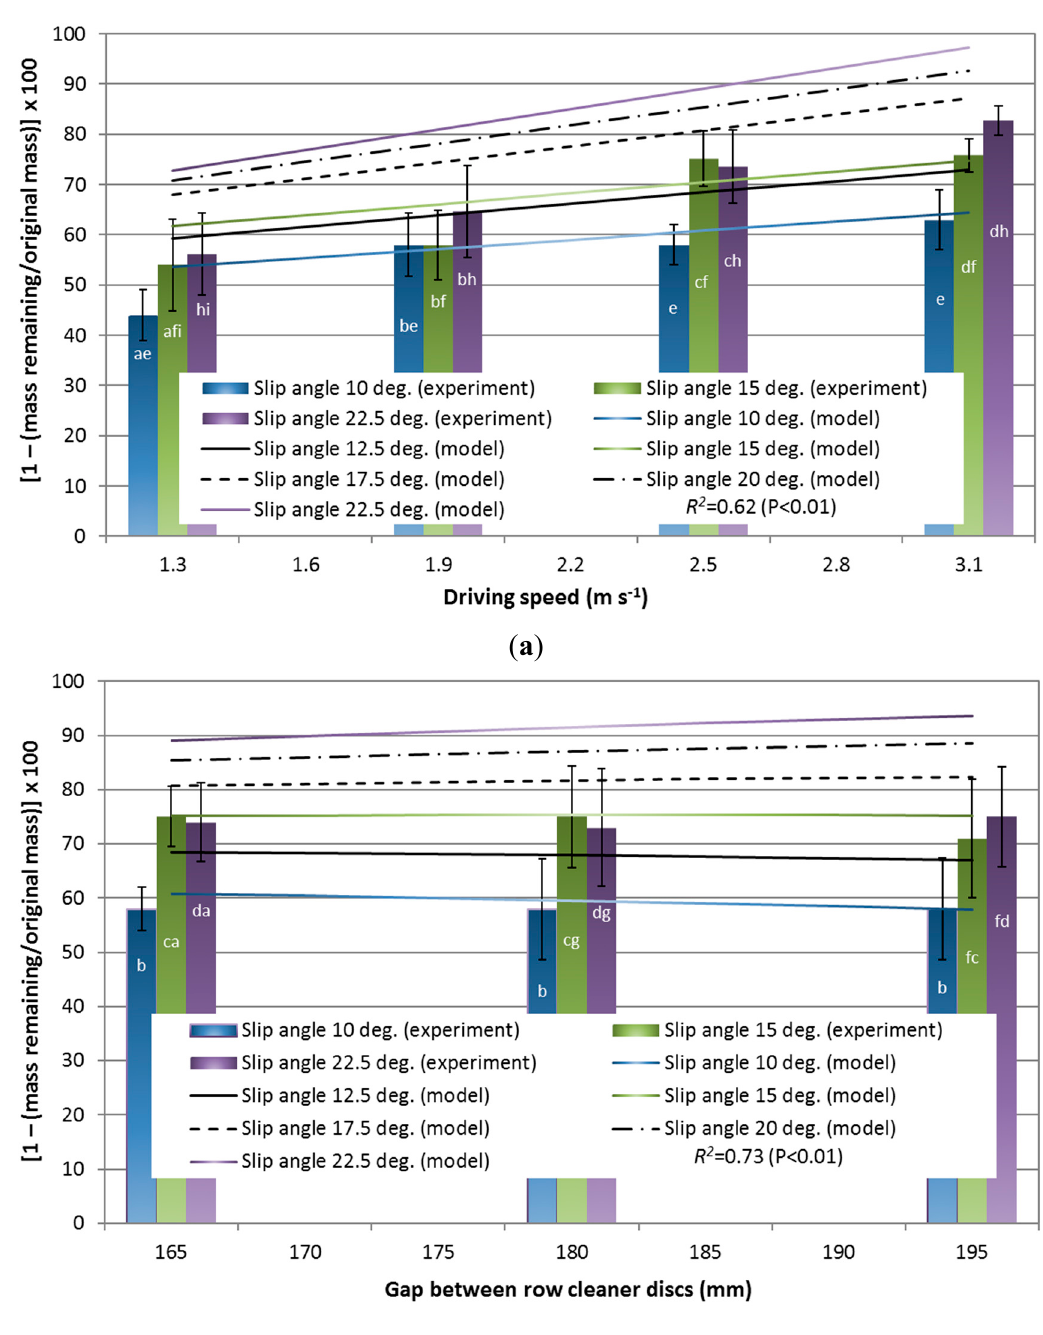
Figure 6. Amount removed from the strip plant residue depending on the slip angle and the driving speed when the gap between the discs B lc is constant (165 mm) ( a ), and on gap B lc , when the driving speed is constant (2.5 m s − 1 ) ( b ). The different letters indicate that there are significant differences among the treatments at p < 0.05.